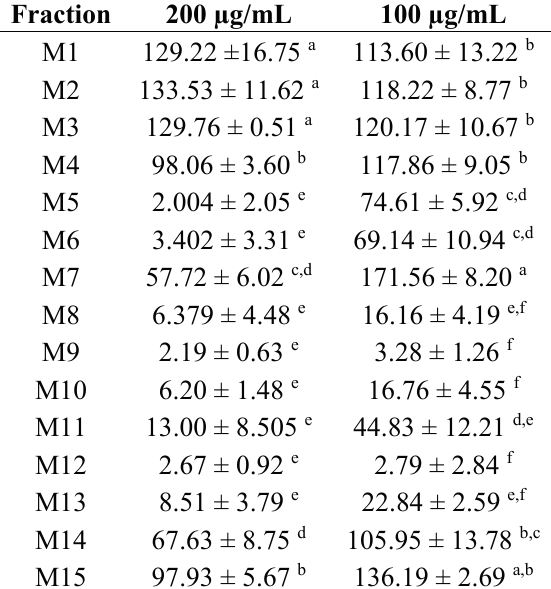
Table 2. Percentage of proliferation of M12.C3.F6 murine cells exposed to methanolic fractions at different